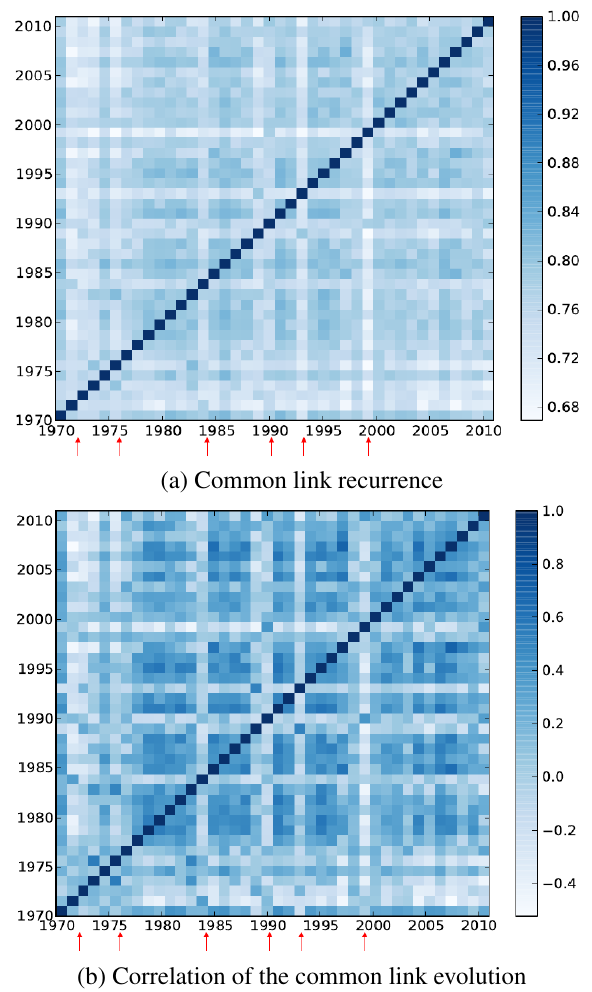
Figure 5. Common-links-recurrence diagram (a) and correlation Fig. 5: Common-links-recurrence-diagram (a) and correla- matrix of the common link evolution (b) . Each point (i,j) in di- tion matrix of the common link evolution (b). Each point agram (b) corresponds to the value of the correlation coefficient ( i,j ) in diagram (b) corresponds to the value of the corre- corr (i,j) between the common component functions CCF (N i ,N k ) lation coefficient corr ( i,j ) between the common component and CCF (N j ,N k ) . Lines with low values (marked at the bottom with arrows) are observable around strong ENSO ,N ) and CCF ( N ,N ) . Lines with low functions CCF ( N i k j k values (marked at the bottom with arrows) are observable around strong ENSO years.